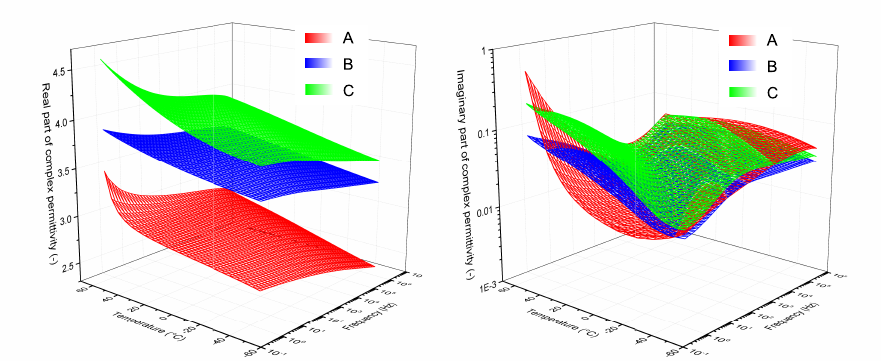
Figure 13. Real and imaginary parts of complex permittivity of investigated composites.